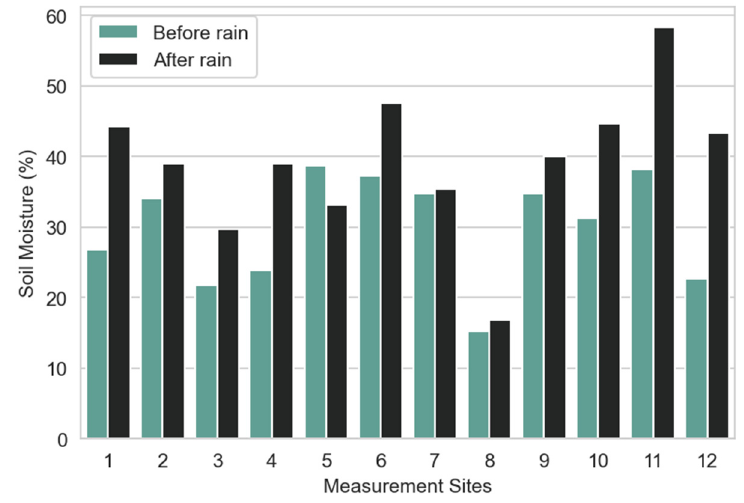
Figure 11. Average soil moisture per measurement site before and after rain.